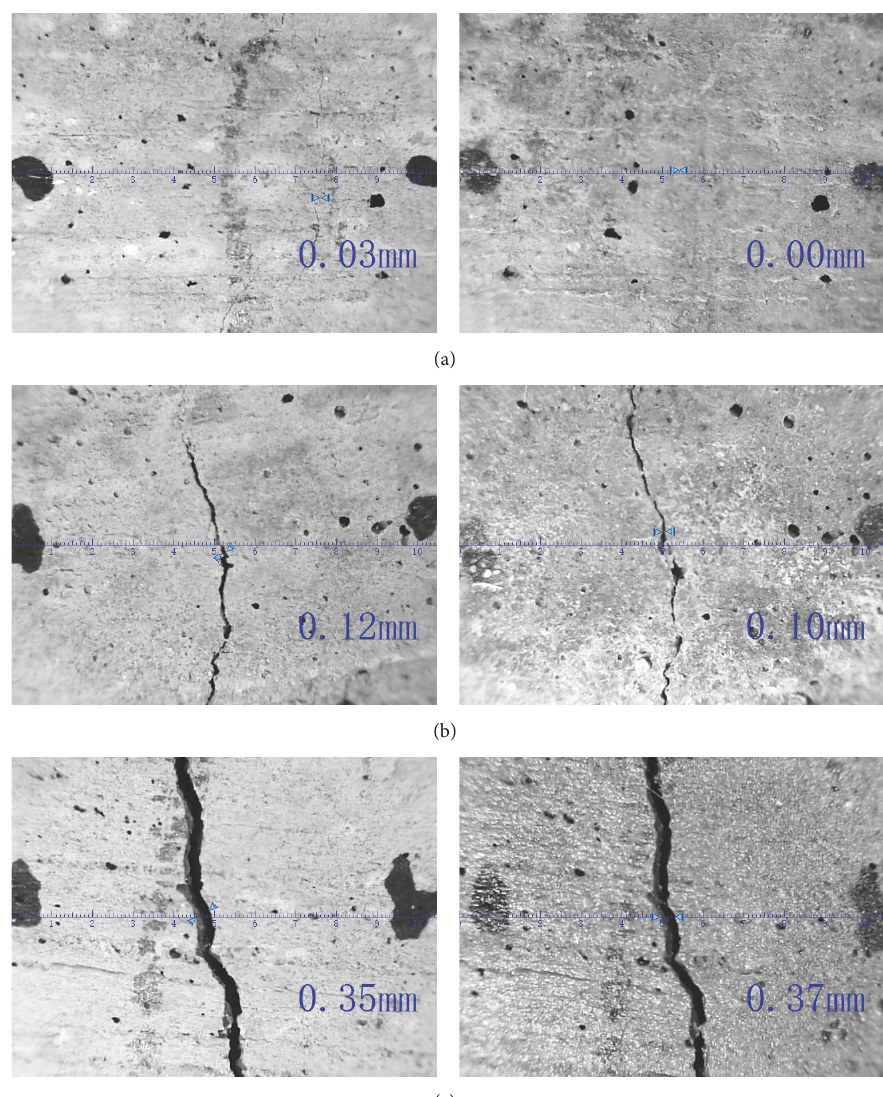
Figure 5: Evolution of crack width before (left) and after (right) w-d cycles: (a) completely self-healing; (b) partly self-healing; (c) remaining